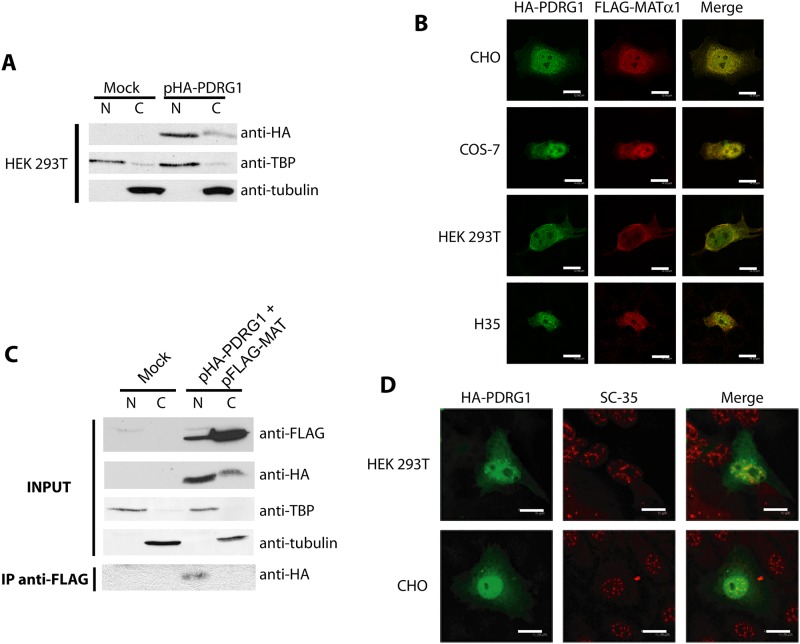
Subcellular distribution of HA-PDRG1 and the HA-PDRG1/ MATα1 interaction.(A) Representative western blots of nuclear (N) and cytoplasmic (C) fractions (50–70 μg) obtained from HEK 293T cells transiently transfected with pHA or pHA-PDRG1 in three independent experiments. Membranes were analyzed using anti-HA, anti-TBP (nuclear marker) and anti-tubulin (cytoplasmic marker). (B) Representative confocal immunofluorescence images (N = 50 per cell line) of CHO, COS-7, HEK 293T and H35 cells transiently cotransfected with pHA-PDRG1 and pFLAG-MAT obtained using mouse anti-HA, rabbit anti-MATα1 and the corresponding secondary antibodies coupled to Alexa Fluor 488 (green) or 546 (red). Colocalization of both proteins is shown in yellow (scale bar = 12 μm) (C) Representative results of anti-FLAG immunoprecipitations carried out in N and C fractions obtained from HEK 293T cells transiently cotransfected with pFLAG-MAT and pHA-PDRG1 or the empty plasmids (mock). Input fractions were analyzed using anti-FLAG, anti-HA, and antibodies against nuclear and cytoplasmic markers, whereas immunoprecipitates were examined using anti-HA. Results correspond to a minimum of three independent experiments. (D) Representative confocal immunofluorescence images of nuclear matrix preparations of HEK 293T and CHO cells overexpressing HA-PDRG1 using rat anti-HA (green), mouse anti-SC-35 (red) and appropriate secondary antibodies conjugated to Alexa Fluor dyes (N = 50 per cell line); colocalization appears in orange. Scale bar = 12 μm.